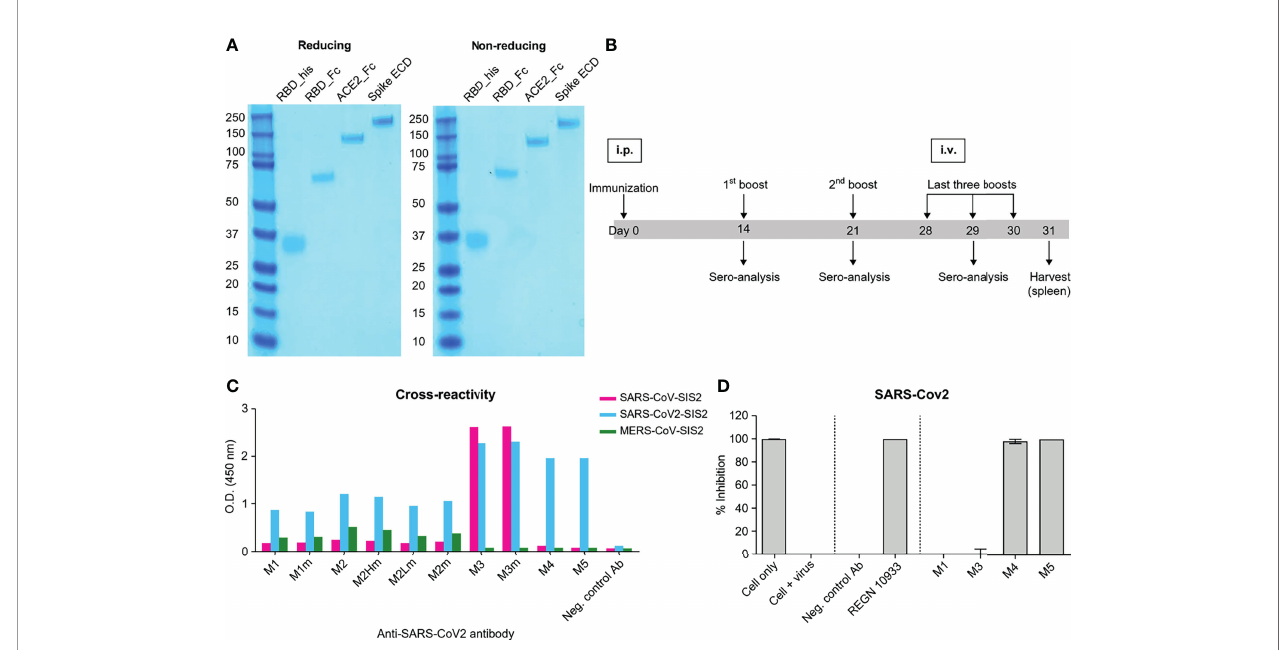
FIGURE 1 | Mouse immunization and in vitro screening of anti-SAR-CoV-2 chimeric mAbs. (A) SDS-PAGE of recombinant proteins puri fi ed from Expi293F cells. SDS-PAGE was performed in reducing (left) and non-reducing conditions (right). All the proteins were expressed as monomers; the same band patterns were observed in both conditions. (B) A schematic of the mouse immunization protocol. Immunization, 1 st , and 2 nd booster doses were administered by intraperitoneal injections of 100 µg of RBD mono-Fc. Last three booster doses were injected intravenously with 50 m g of RBD mono-Fc. (C) Binding analysis of chimeric mAbs against beta-coronavirus spike proteins. M3, M4, and M5 clones signi fi cantly bind to the SARS-CoV-2 spike protein. The M3 clone was cross-reactive to both SARS-CoV and SAR-CoV-2. (D) Inhibition screening against SARS-CoV-2 pseudovirus for chimeric mAbs. Each mAb was tested by luciferase assay system. The inhibition of SARS-CoV-2 pseudovirus by the antibodies in human ACE2-overexpressed HEK293 cells was measured in luciferase units. Anti-CEACAM1 antibody is the isotype